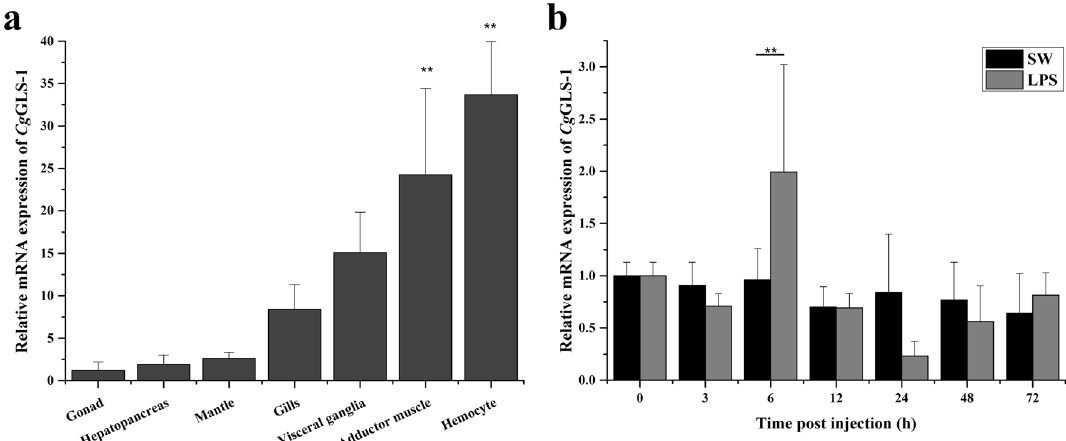
Figure 3. The mRNA expression profile of Cg GLS-1. ( a ) The relative mRNA expression levels of Cg GLS-1 mRNA in different tissues detected by qRT-PCR. Data were represented as the ratio of Cg GLS-1 mRNA level to that of gonad and normalized to that of Cg EF. ( b ) The mRNA expression patterns of Cg GLS-1 in oyster hemocytes after LPS stimulation. Data were represented as the ratio of Cg GLS-1 mRNA level to that of 0 h and normalized to that of Cg EF. Comparison of the level of Cg GLS-1 mRNA (relative to Cg EF) was normalized to 0 h. Each value is shown as mean ± S.D. (N = 3). Asterisks indicate significant differences. (** p < 0.01).